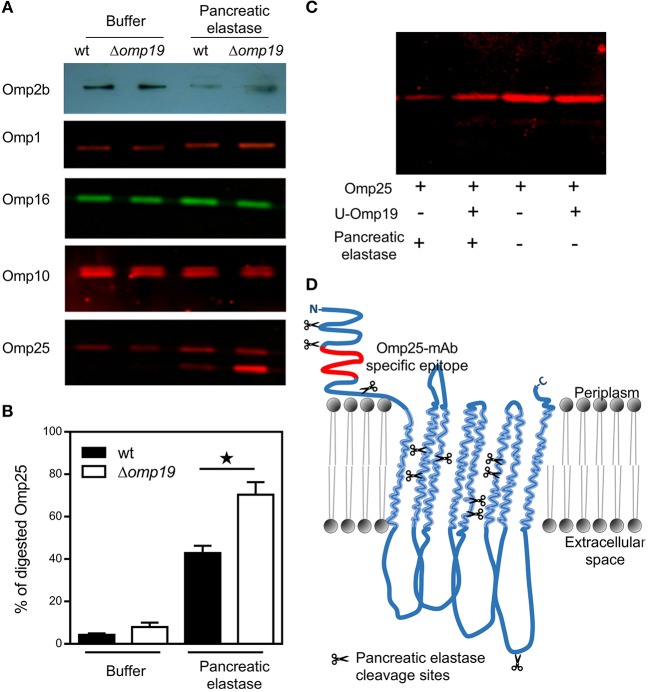
Omp19 on the B. abortus membrane protects Omp25 from pancreatic elastase digestion. Wt and Δomp19 B. abortus strains were incubated with buffer (10 mM Tris-HCl, pH8.8) or pancreatic elastase. (A) Equal quantities of bacteria were subjected to SDS-page followed by western blot analysis using specific antibodies for cell envelope proteins: Omp2b, Omp1, Omp16, Omp10, and Omp25. Images are representative from two or three independent experiments. (B) Percentage of digested Omp25 evaluated by quantitative analysis of western blot images. Data represent pooled results from two independent experiments (*p < 0.05 vs. wt B. abortus strain in pancreatic elastase). (C) Recombinant purified Omp25 was incubated with pancreatic elastase with or without U-Omp19. Following incubation, each mixture of reaction was separated on SDS-PAGE followed by western blot analysis with Omp25 specific antibodies. (D) Graphical representation of BOCTOPUS (31) or PRED-TMBB2 (32) transmembrane β-barrel predicted topology for Omp25 with respect to the lipid bilayer representation of the B. abortus outer membrane. Scissors indicate predicted pancreatic elastase cleavage sites (AA or AG) on Omp25 sequence. The position of the specific epitope for the anti-Omp25 mAb used is colored in red.